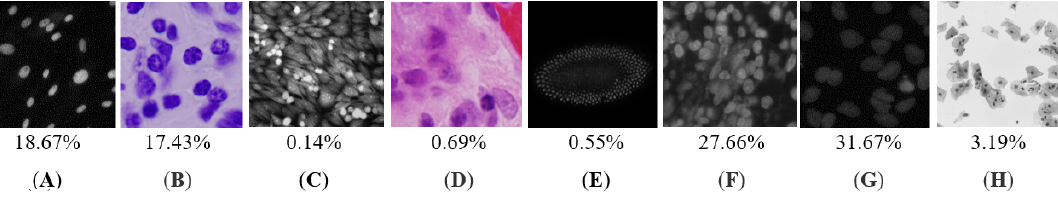
Figure 1. A diverse set of images and their proportions in the set: ( A , B ) Typical cases with a clear view; ( C , D ) rare instances surrounded by histological structures; ( E ) heavily clustered nuclei; ( F ) blurriness and a high level of overlapping; ( G ) an extremely high level of blurriness; and ( H ) an extremely high level of